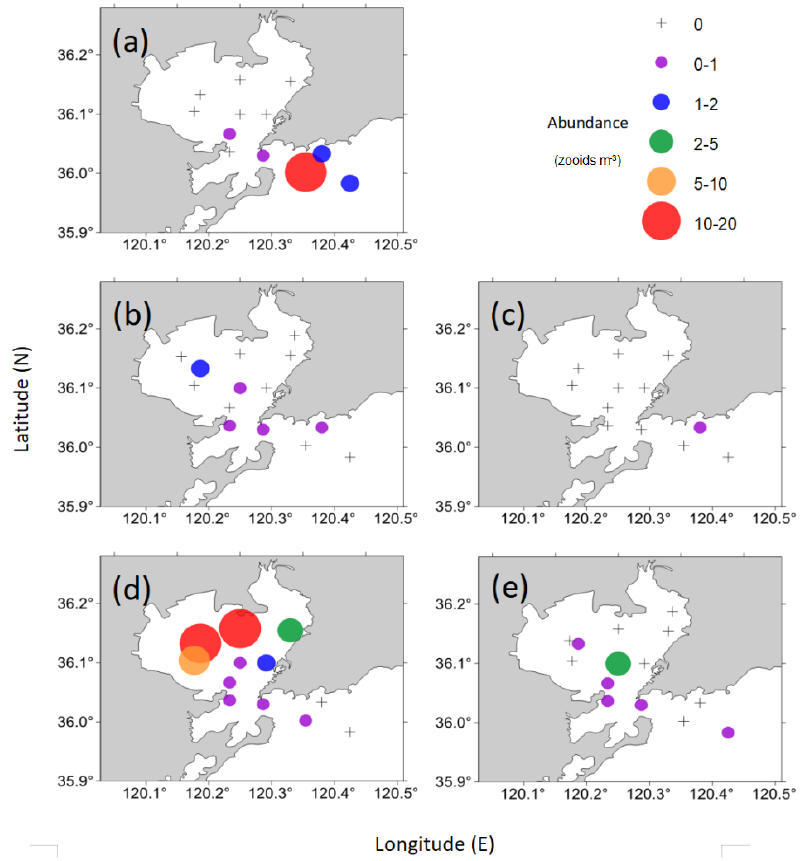
Figure 2. Abundance of Dolioletta gegenbauri (zooids m − 3 ) in the Jiaozhou Bay in October 2019 ( a ), summed for all life stages at each station.